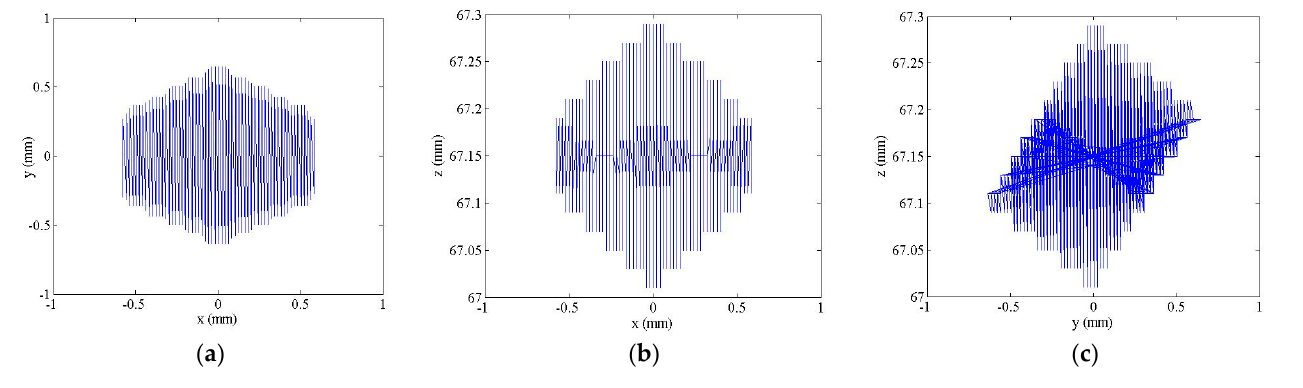
Figure 11. Plane workspace ( a ) X - Y ; ( b ) X - Z ; ( c ) Y - Z .